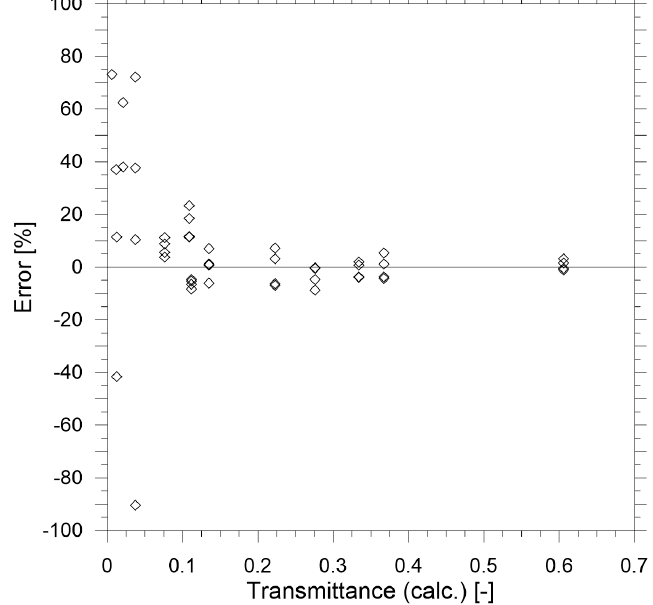
Figure 8. The relative error of transmittance measurements compared to known transmittance value of the calibration filters.